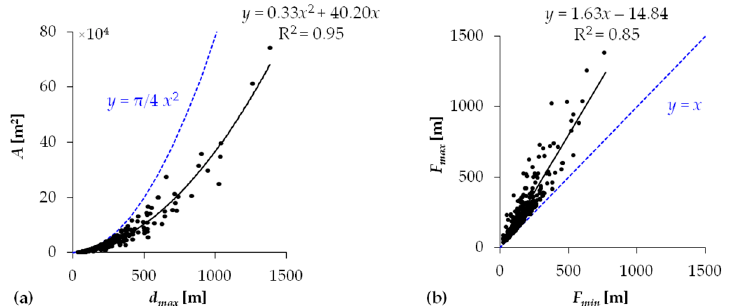
Figure 6. Relationship between ( a ) maximum diameter ( d max ) and area ( A ), and ( b ) minimum ( F min ) and maximum ( F max ) Feret diameters of the 344 tells mapped within the test area.